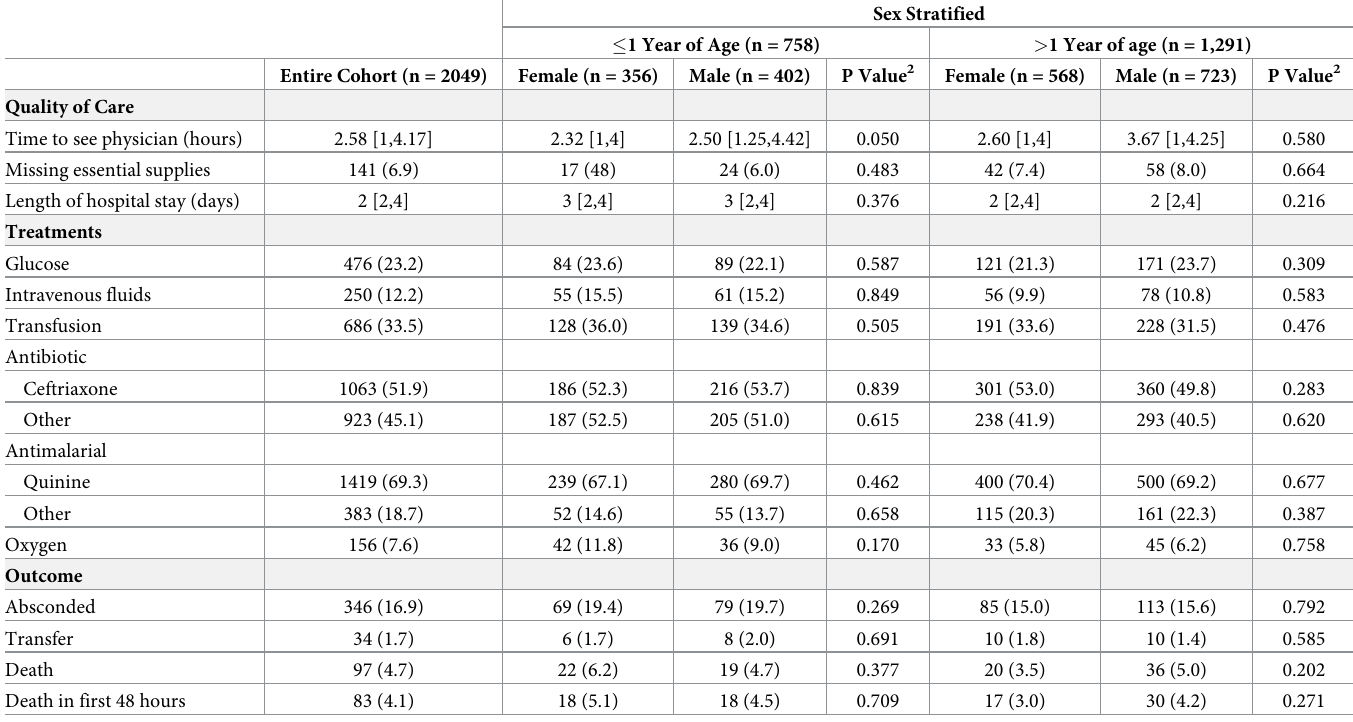
Table 3. Quality of clinical care, treatment, and clinical outcome by sex.